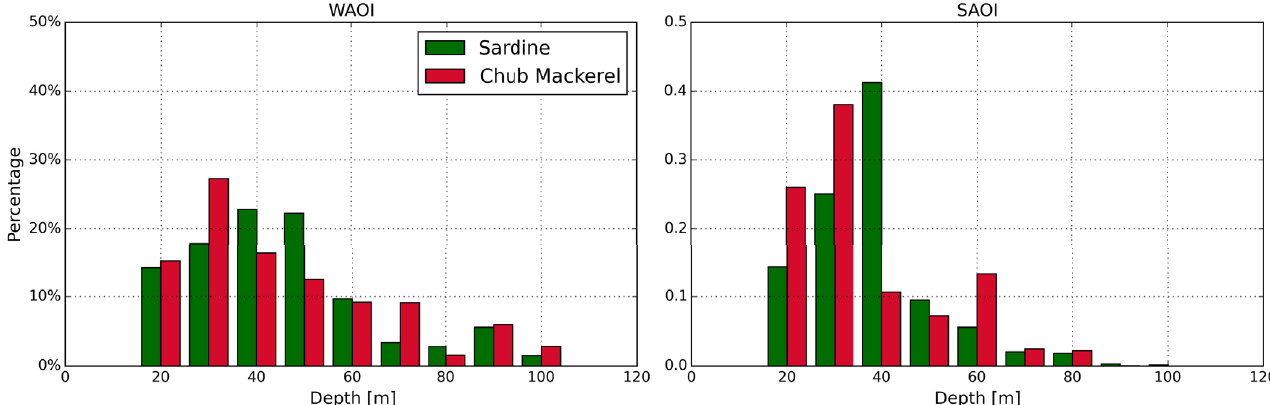
Fig. 1. Sardine and chub mackerel relative catches as a function of bottom depth for the Western Area of Interest (left) and the Southern Area of Interest (right) off the Portuguese coast.